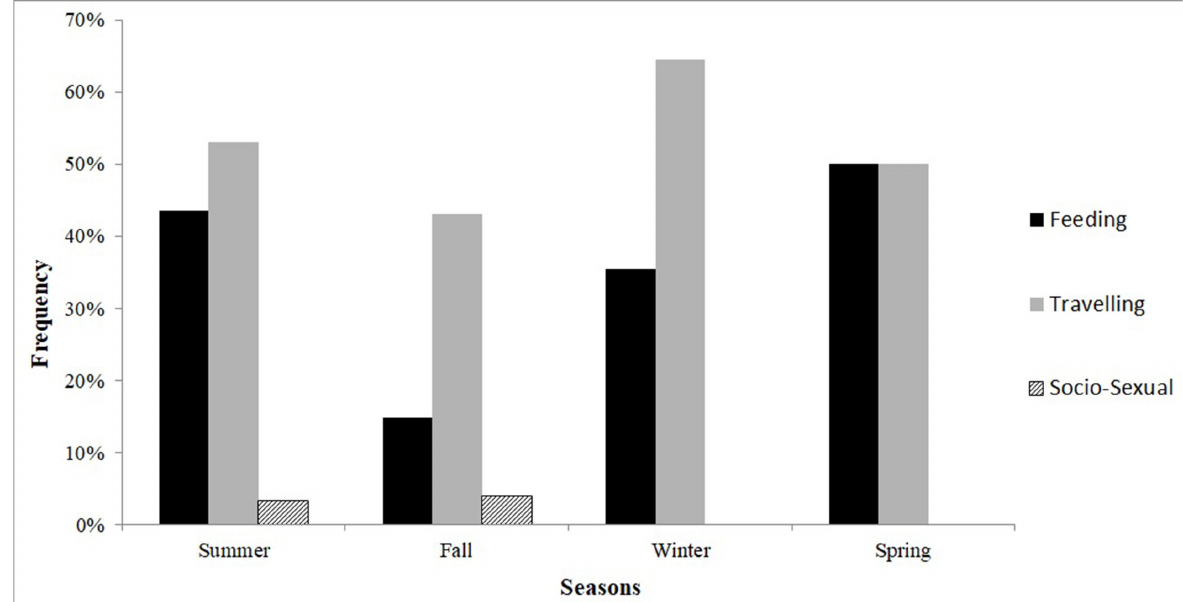
Figure 4. Frequency of Tursiops truncatus truncatus behaviors (Feeding, Travelling and Socio-sexual) among seasons in Cabo Frio coast, Rio de Janeiro, Southeastern